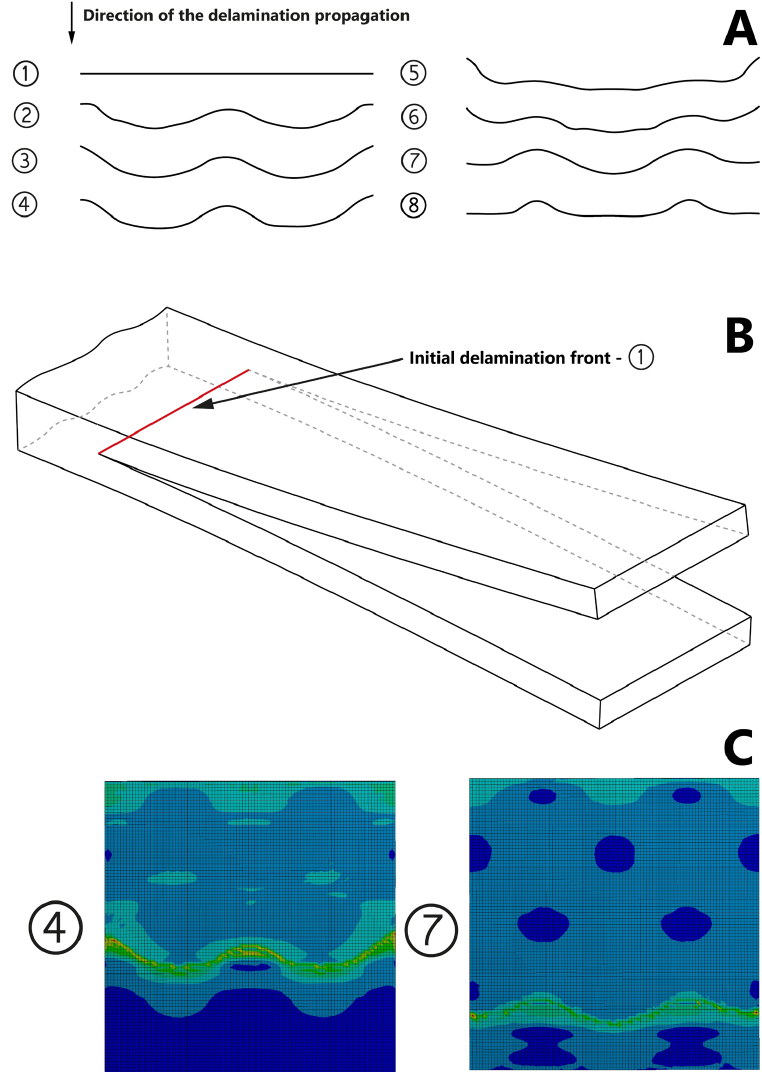
Figure 10. Shapes of the delamination front during loading. Numbers correspond to the specific points marked in Figure 8 . A – different shapes observed. B – scheme of the initial front shape. C – example images of equivalent stresses observed at the delamination